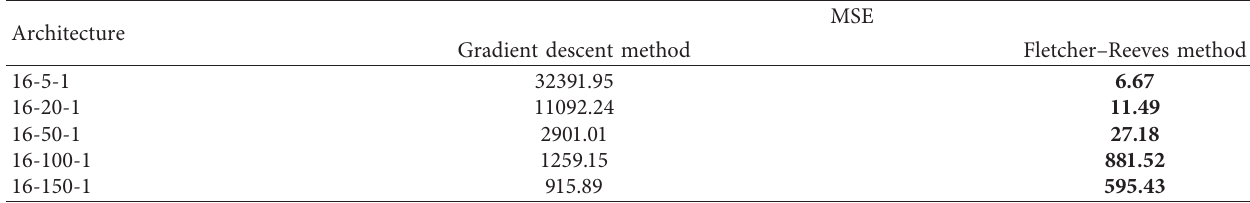
Table 5: Evaluation of the performance of the prediction method for the number of COVID-19 sufferers by using testing data for several architectures for a learning rate equal to 0.005.